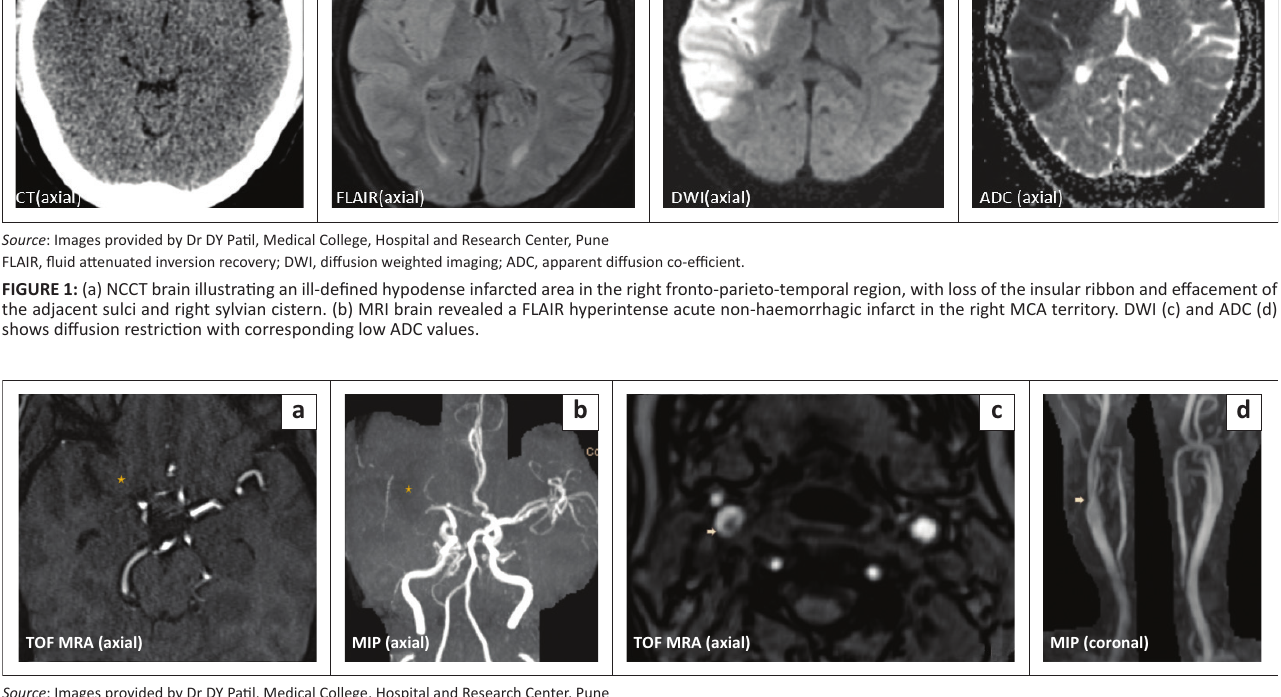
FIGURE 2 : Magnetic resonance angiography TOF axial (a) and reformatted axial (b) demonstrating absent flow in all segments of the right MCA (star). Axial plane MRA of the neck vessels (c) revealed a curvilinear intra-luminal filling defect along the posterior wall of the right ICA at its origin (arrow) – suspicious of possible dissection or focal atherosclerotic plaque/thrombus. MIP coronal (d) exhibits subtle narrowing at the right carotid bifurcation.(arrow)